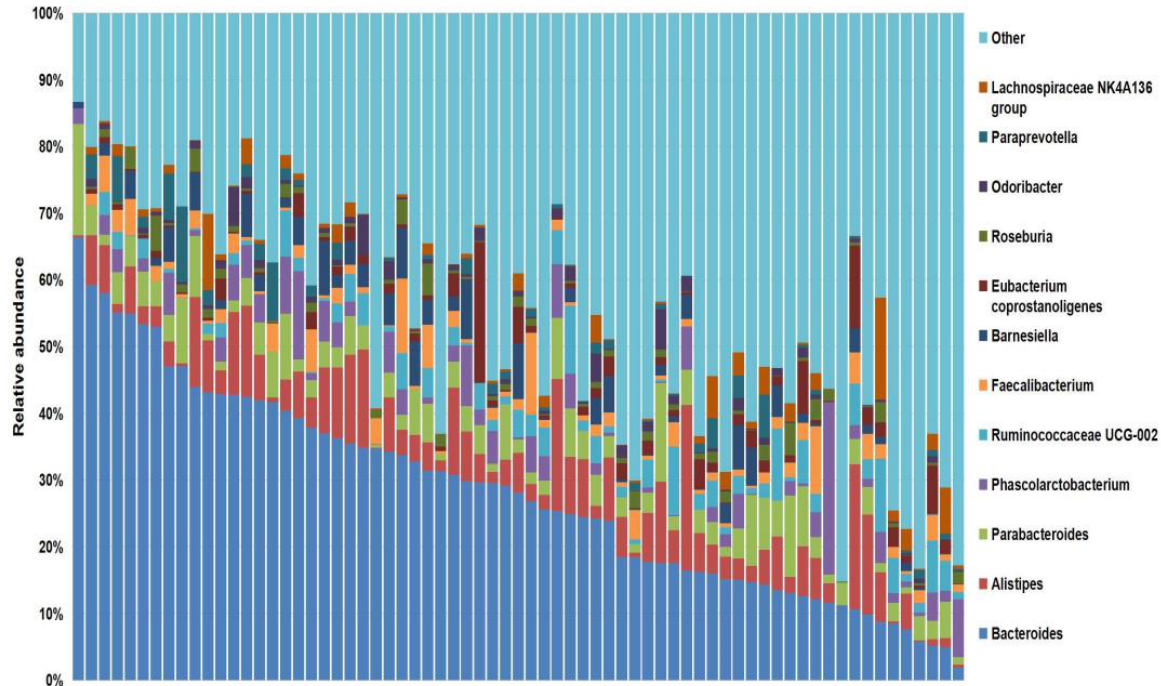
Figure 1. Stacked bar plot of the phylogenetic composition of the most common taxa at the genus level. Bacteroides , in dark blue, was the most frequent genera identified within the cohort.